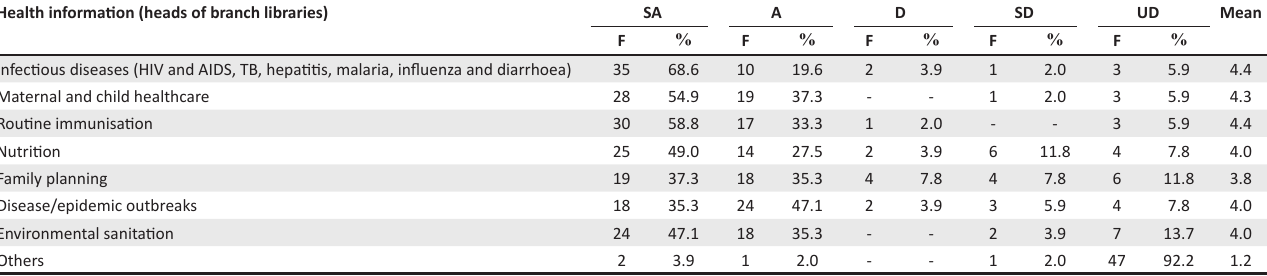
TABLE 6: Opinions of the heads of branch libraries on health information needs of the rural dwellers ( N = 51). Health information (heads of branch